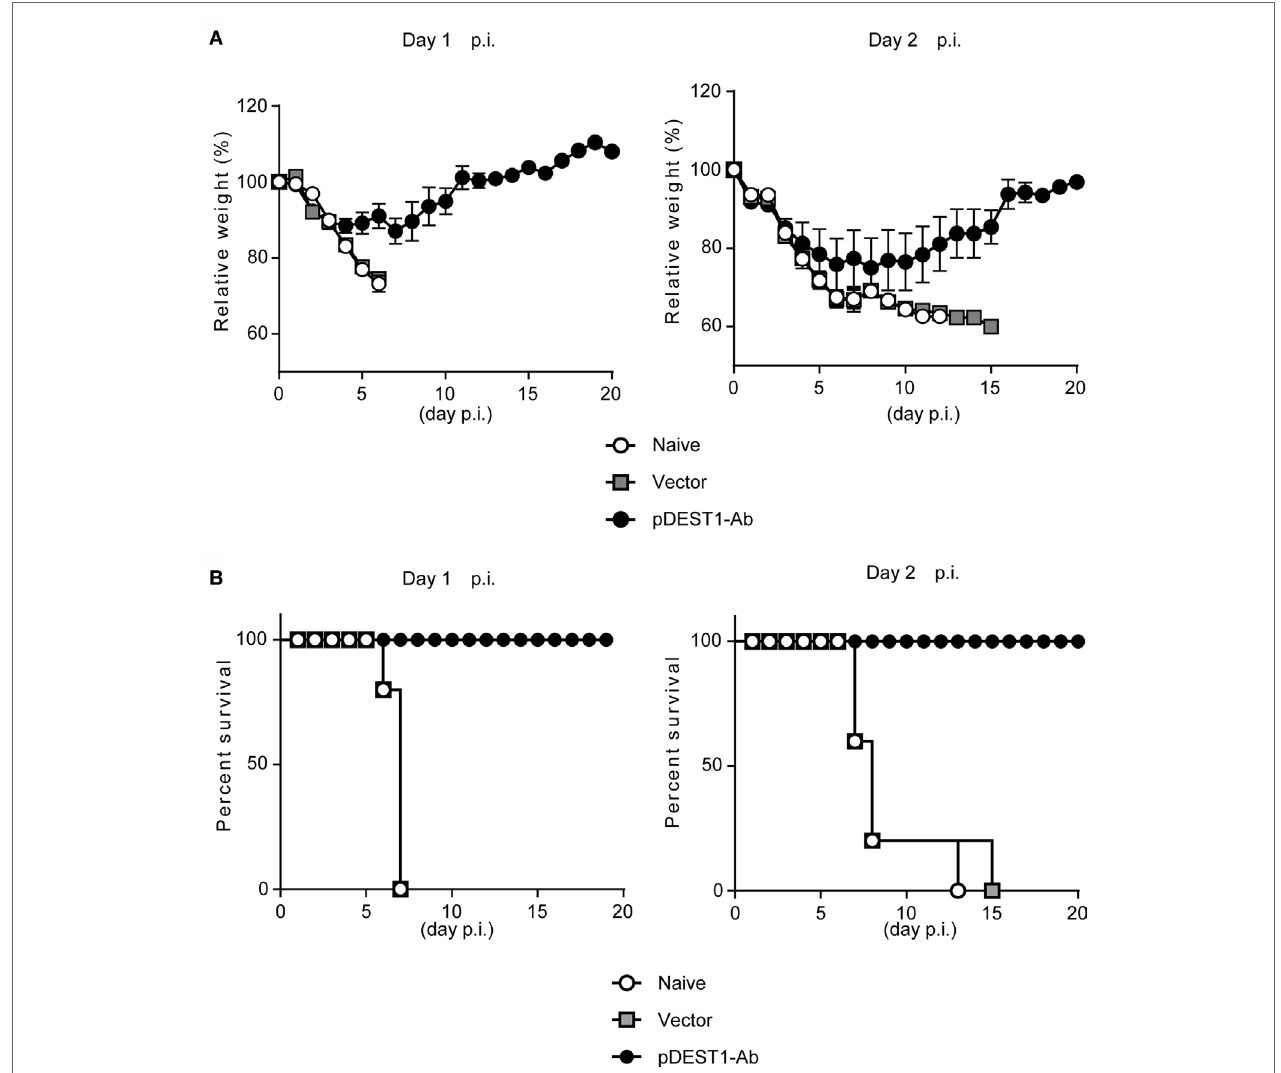
FigUre 3 | HD protects mice from a lethal dose of influenza virus infection. (a,B) BALB/c mice were subjected to HD with either pDEST1-empty (vector) or pDEST1-Ab encoding anti-HA IgG at 1 or 2 days post-infection with a lethal dose (1,000 TCID 50 ) of A/PR8 virus ( n = 5). The body weight (a) and survival rates (B) were monitored for 20 days. Body weight was expressed relative to the initial mean body weight of each group. Error bars represent the SEM. The indicated data from “Day 2 p.i.” are representative of two independent